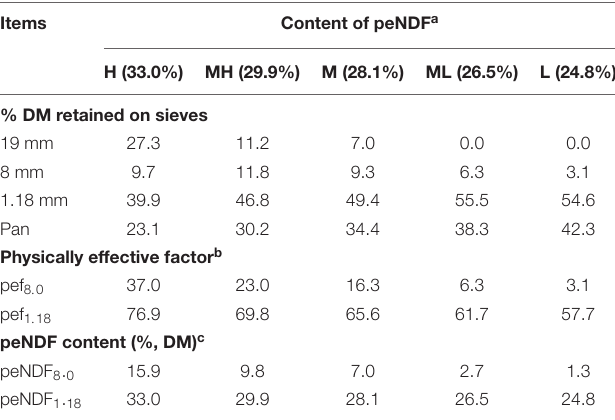
TABLE 1 | PS distribution and peNDF content of five